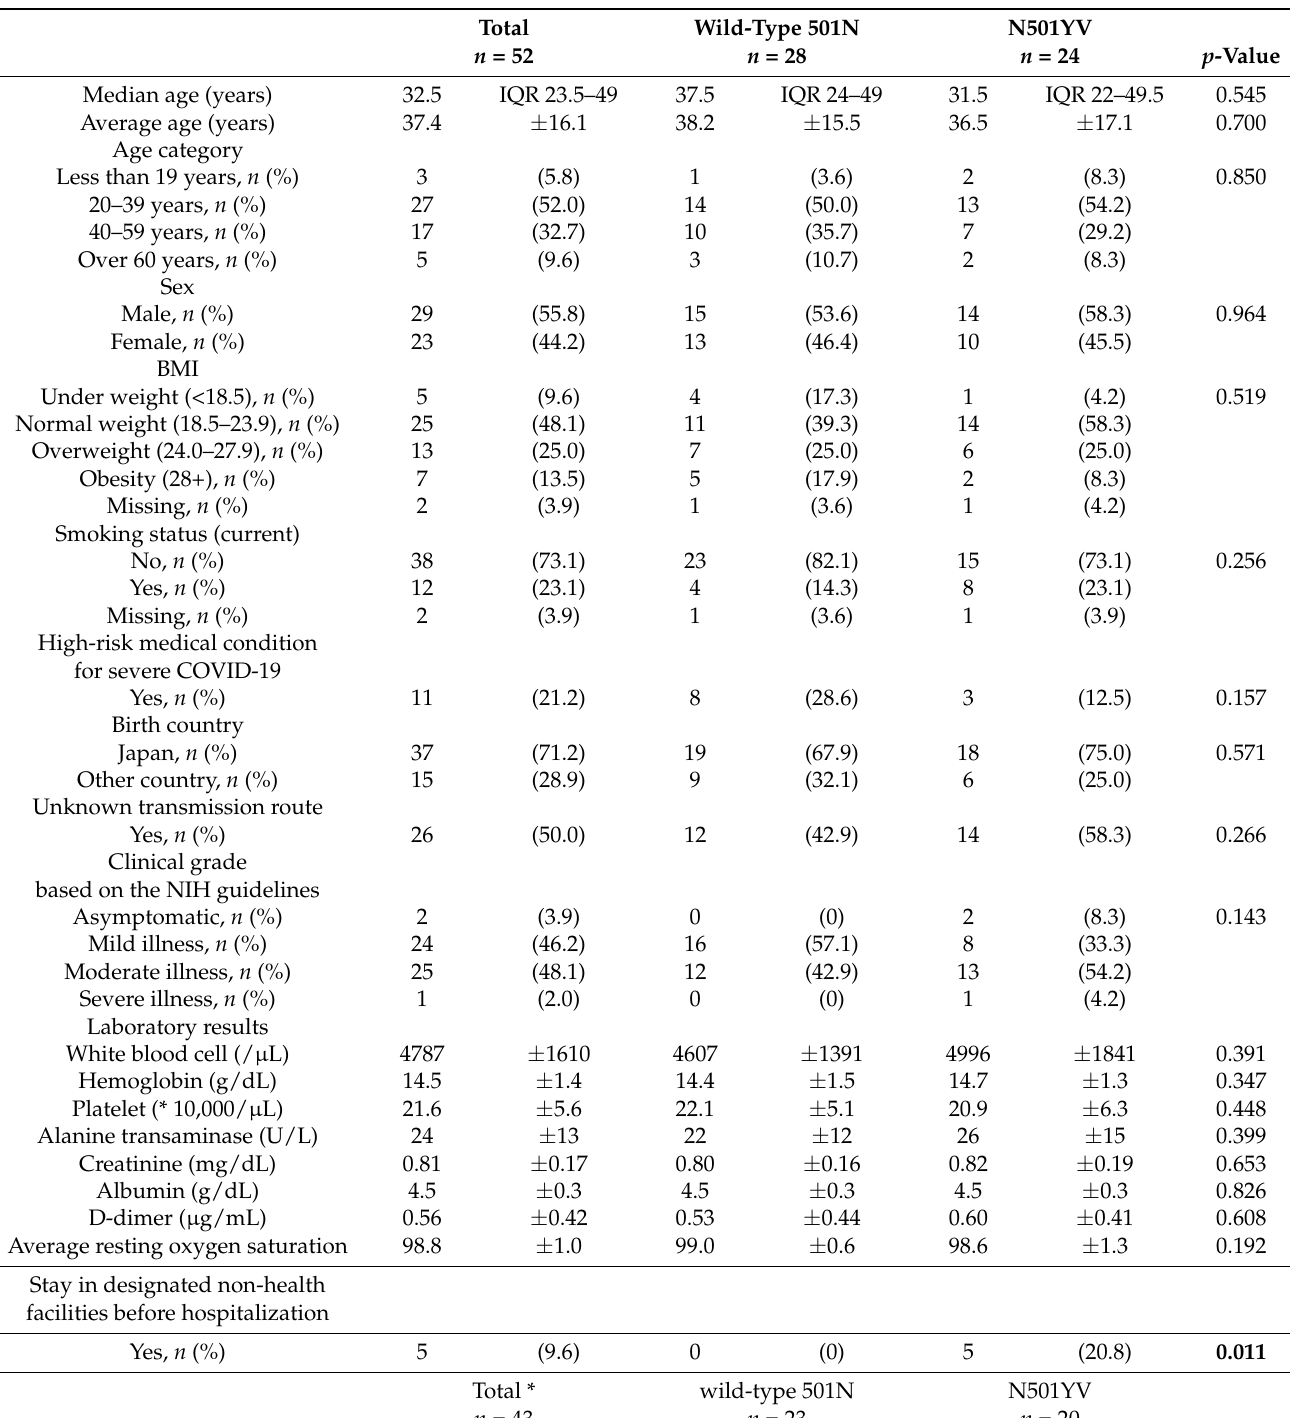
Table 1. Baseline characteristics for the patients infected with wild-type 501N and